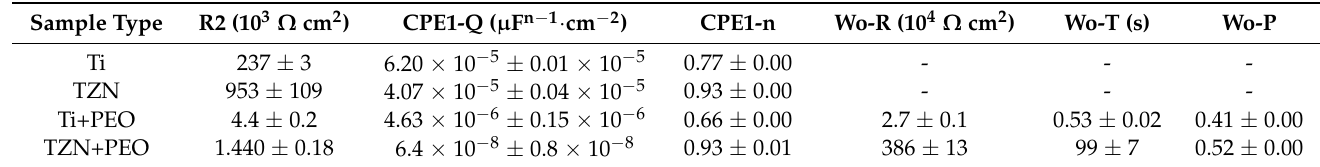
Table 5. EIS fit results of the parameters of the equivalent circuits for the uncoated and PEO coated samples tested in Ringer’s